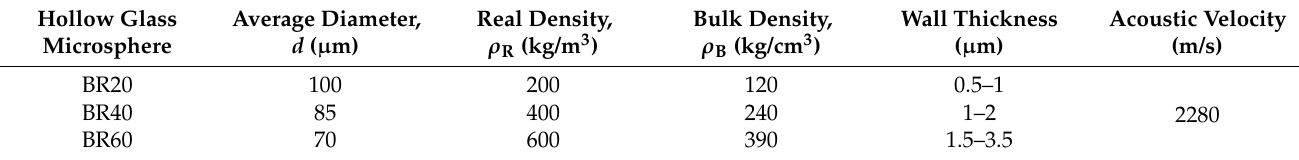
Table 2. Hollow glass bead parameter